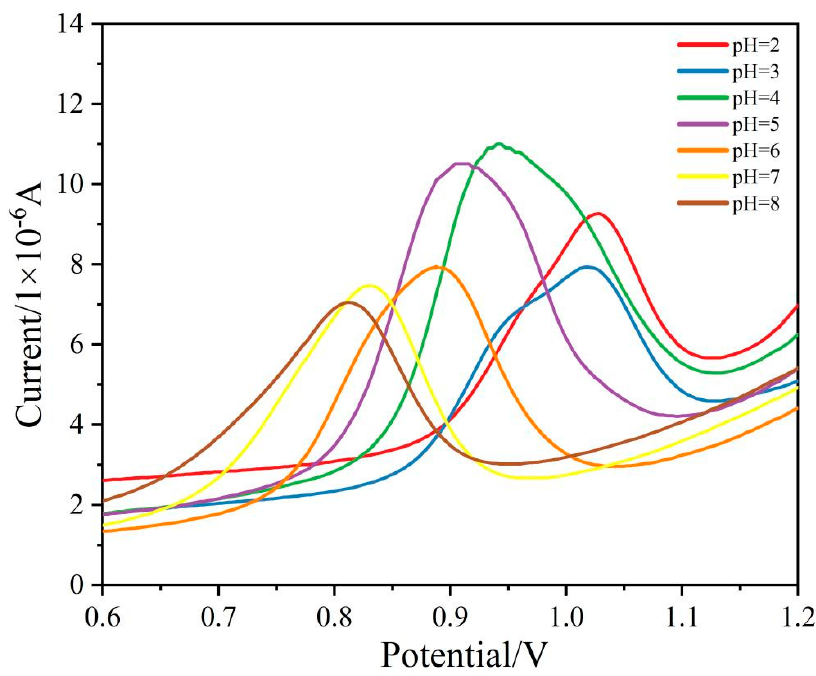
Figure 4. Differential pulse diagram of SDZ detection under different pH conditions.